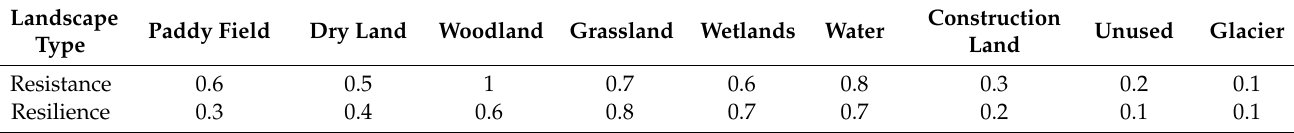
Table 2. Resistance and resilience